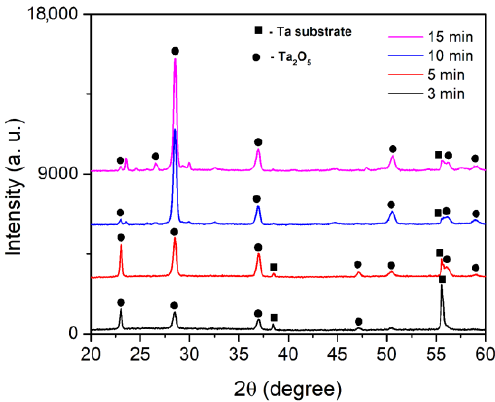
Figure 5. XRD patterns of coatings formed at various stages of the MDs.